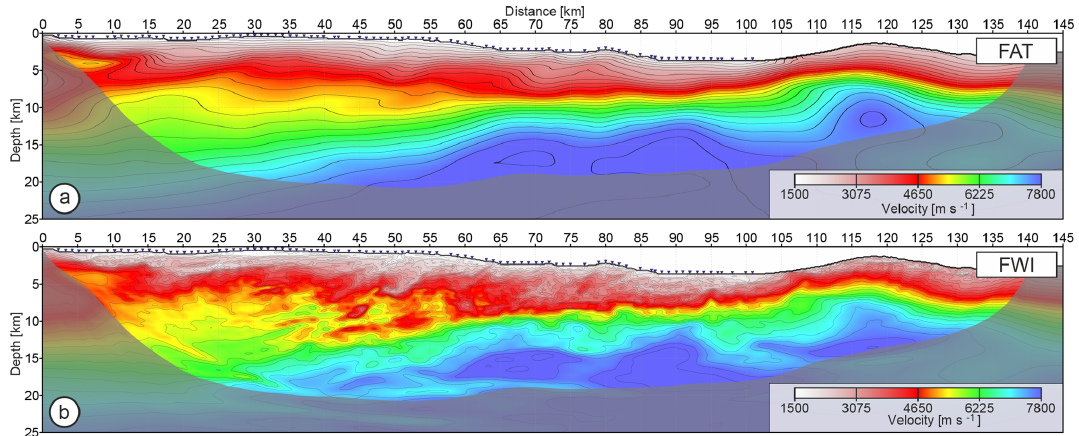
Figure 3. Velocity models derived from the OBS data using FAT (a) and FWI (b) . Triangles at the seafloor represent positions of the OBSs. Note that there is no OBS coverage above 102km of distance. Shading mask corresponds to the area not covered by first-arrival rays.